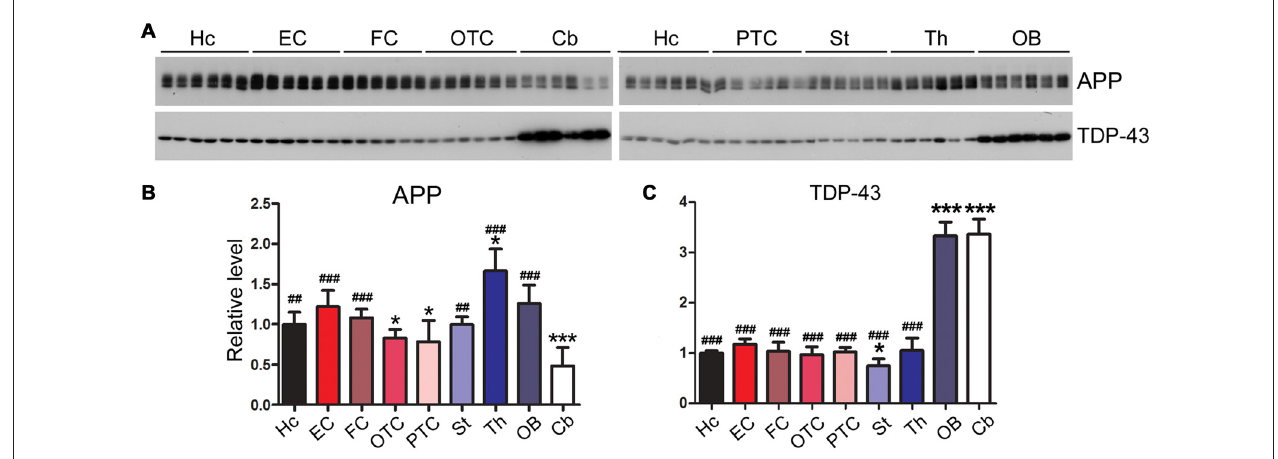
FIGURE 8 | Expression profiles of neurodegeneration related proteins vary in different regions of the rat brain. Western blots (A) were used to characterize the expression levels of neurodegeneration associated proteins, APP (B) and TDP-43 (C) , in nine regions of rat brain. Data are expressed as mean ± SD, which represents matched observations of individual brain regions in six rats. ∗ Compared to EC; # compared to cerebellum. ∗ P < 0.05; ## P < 0.01; ### P <